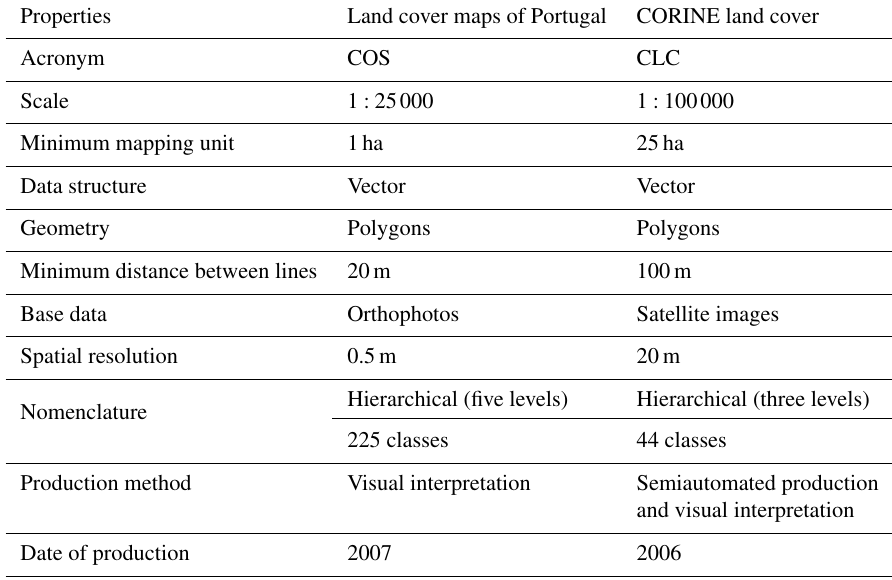
Table 1. Properties of LUC